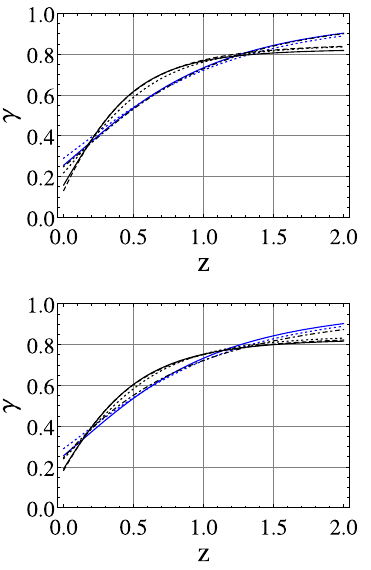
Fig. 2 Evolution of the effective barotropic index. The top panel cor- responds to γ x = 0 and the bottom panel to a fitted γ x , both figures con- sider the analysis JLA + H 0 + H(z). The blue lines represent Λ CDM (solid) and ω CDM (dotted). The black lines are for interacting mod- els, dashed, dotted, dot-dashed and solid lines represent interactions Q 1 , Q 3 , Q 4 and Q , respectively. In both figures Q 2 is indistinguish- able from Q